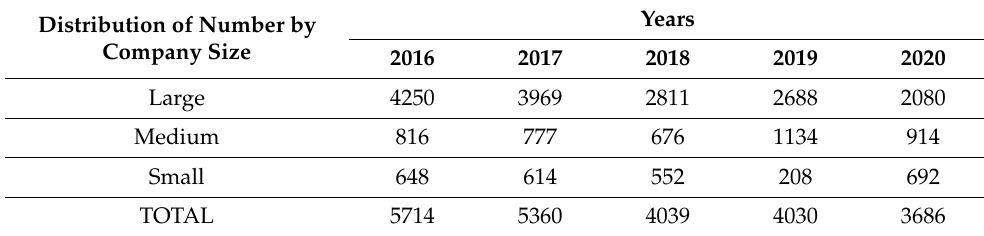
Table 2. Company size